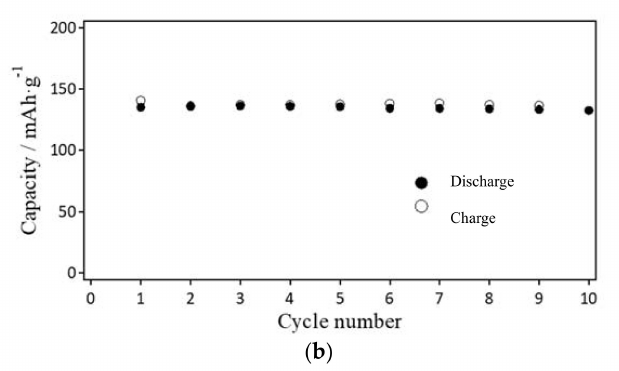
Figure 8. Charge and discharge profile and cyclic performance of the Si/G/CP with 1.0 µ m and 16 wt % Si/1 M LiPF 6 in EC-FEC-DMC (2:2:6 vol. ratio)/LiFePO 4 cell at 0.1 C and 25 ◦